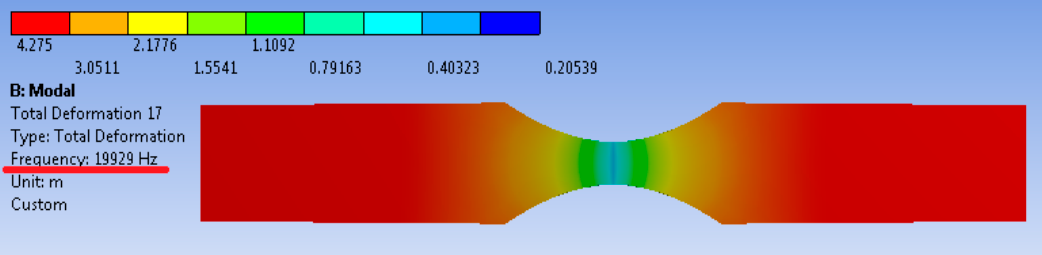
AA7075-T6, obtained by modal analysis.